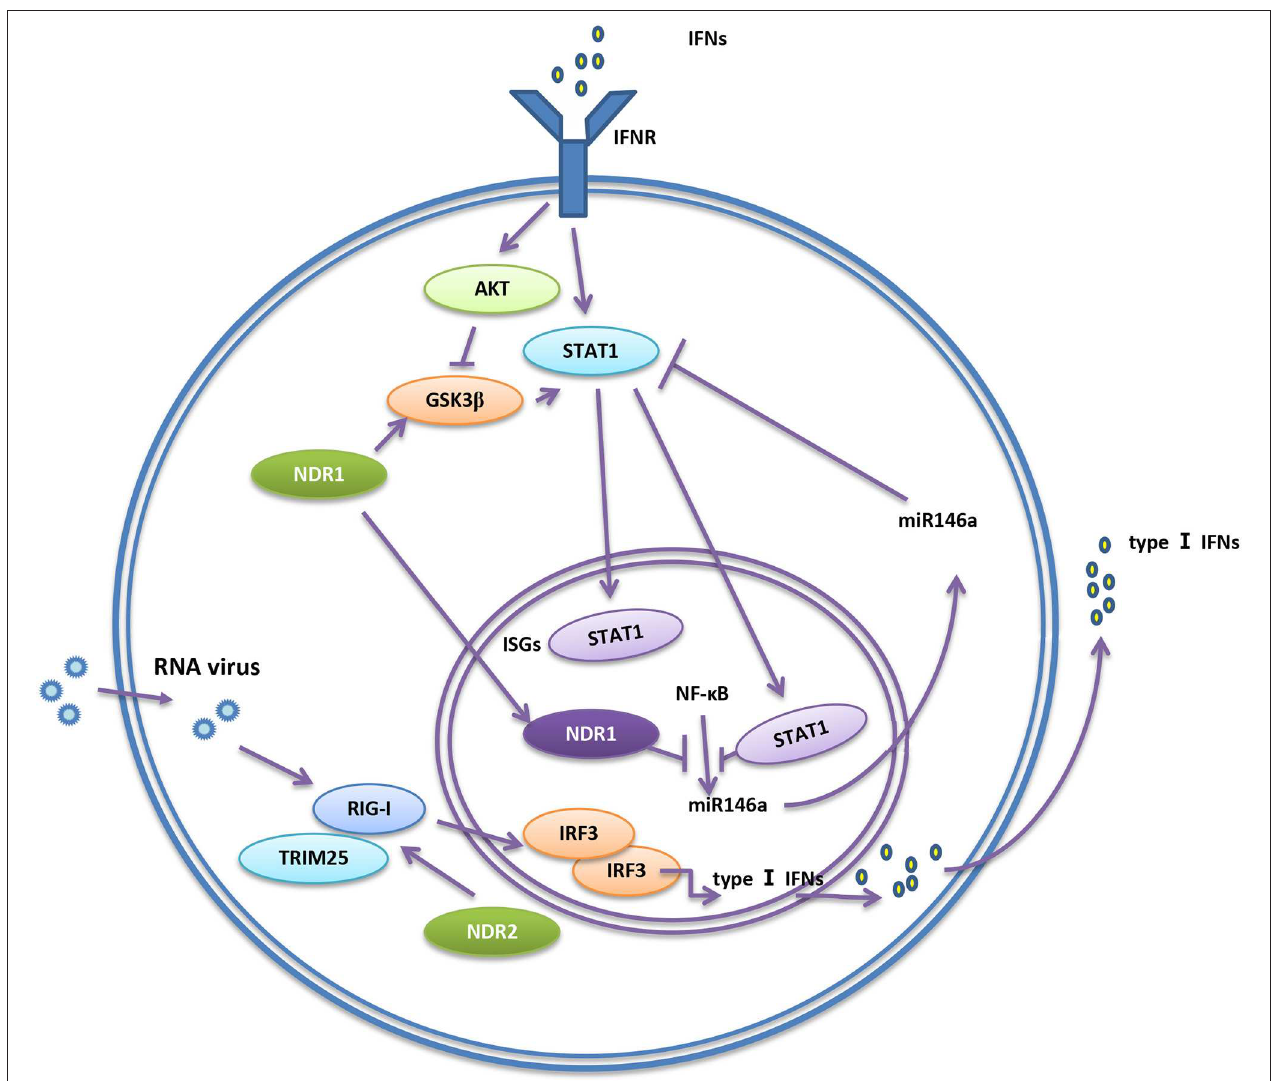
FIGURE 1 | NDR1/2 regulate RIG-I-mediated innate immunity. RIG-I senses virus nucleic acids of viruses and activates downstream signaling pathways to initiate immune response. NDR2 directly associate with RIG-I and TRIM25, thus facilitating the formation of RIG-I/TRIM25 complex and enhancing the polyubiquitination of RIG-I. The ubiquitination of RIG-I further promotes the production of type I IFNs, so the antiviral immune response is enhanced. NDR1 promotes the activity of GSK3 β . GSK3 β promotes the activation of STAT1, then facilitates the expression of IFN-stimulated genes (ISGs). STAT1 is inhibited by miR146a. Binding to